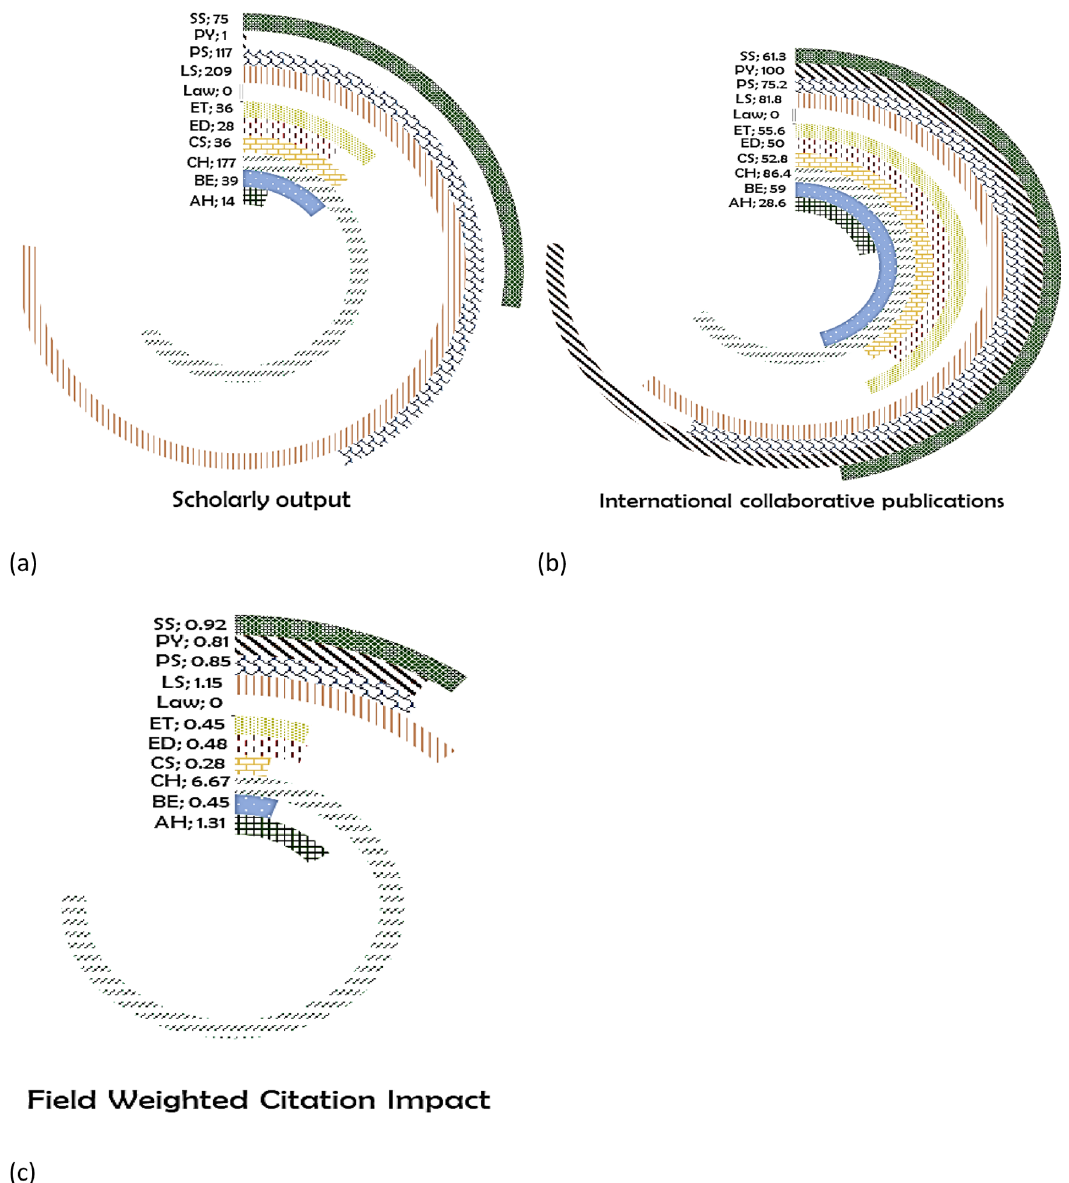
Figure 10. Subject wise split of Bhutan research outcome (a) scholarly output, (b) International collaboration and (c) FWCI. Arts &Humanities (AH),Business and Economics (BE), Clinical, pre-clinical and health (CH), Computer Science (CS), Education (ED), Engineering and Technology (ET), Life Science (LS), Physical Science (PS), Psychology (PY), Social Science